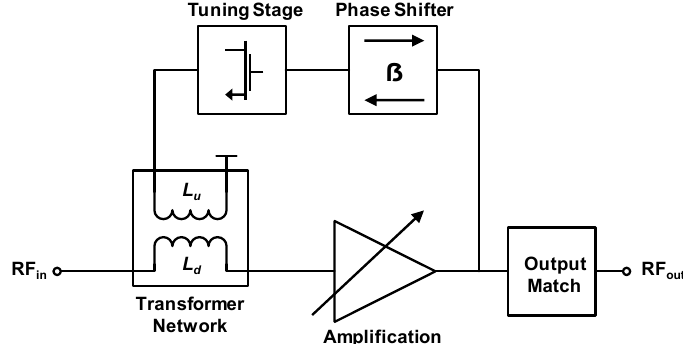
Figure 10. A four-stage LNA design with transformer-based tunable input matching circuit [95].